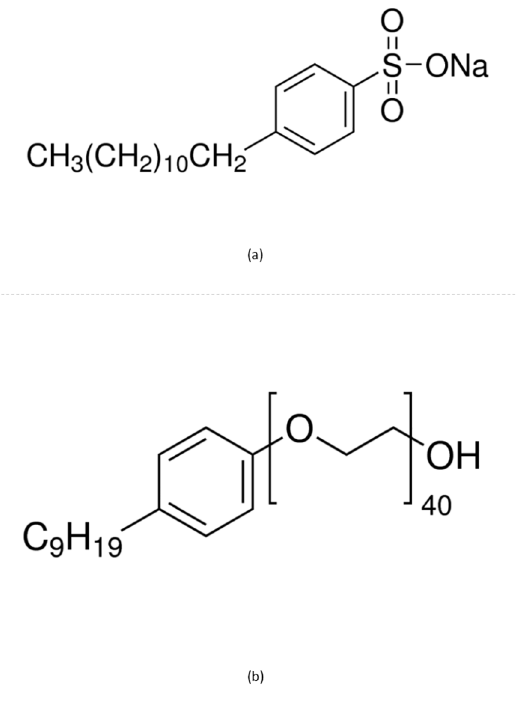
Figure 1. Surfactants chemical formulas. (a) SDBS; (b)